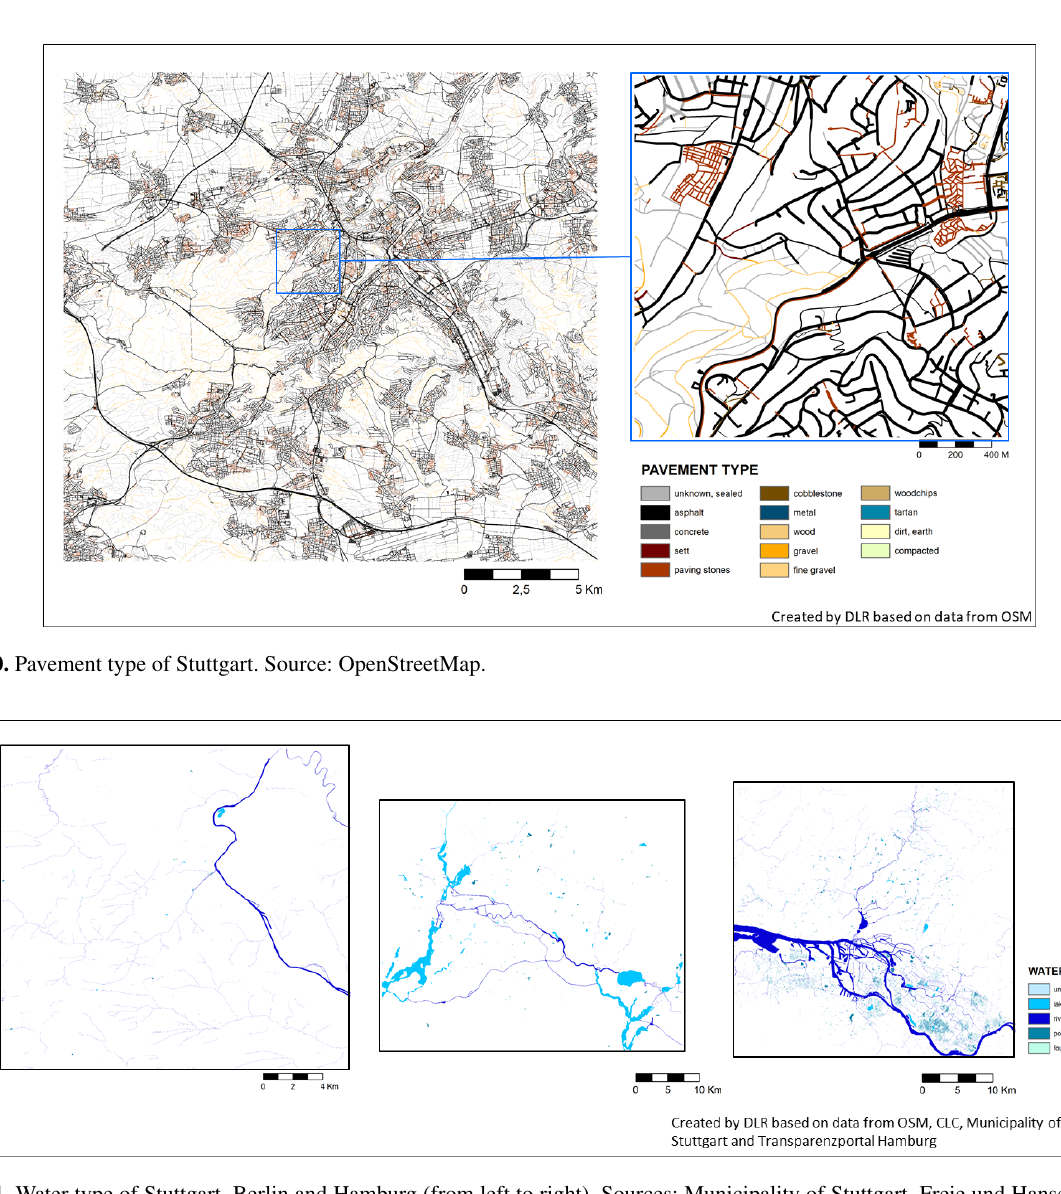
Figure 11. Water type of Stuttgart, Berlin and Hamburg (from left to right). Sources: Municipality of Stuttgart, Freie und Hansestadt Ham- burg, Landesbetrieb Geoinformation und Vermessung, European Union (2017) and